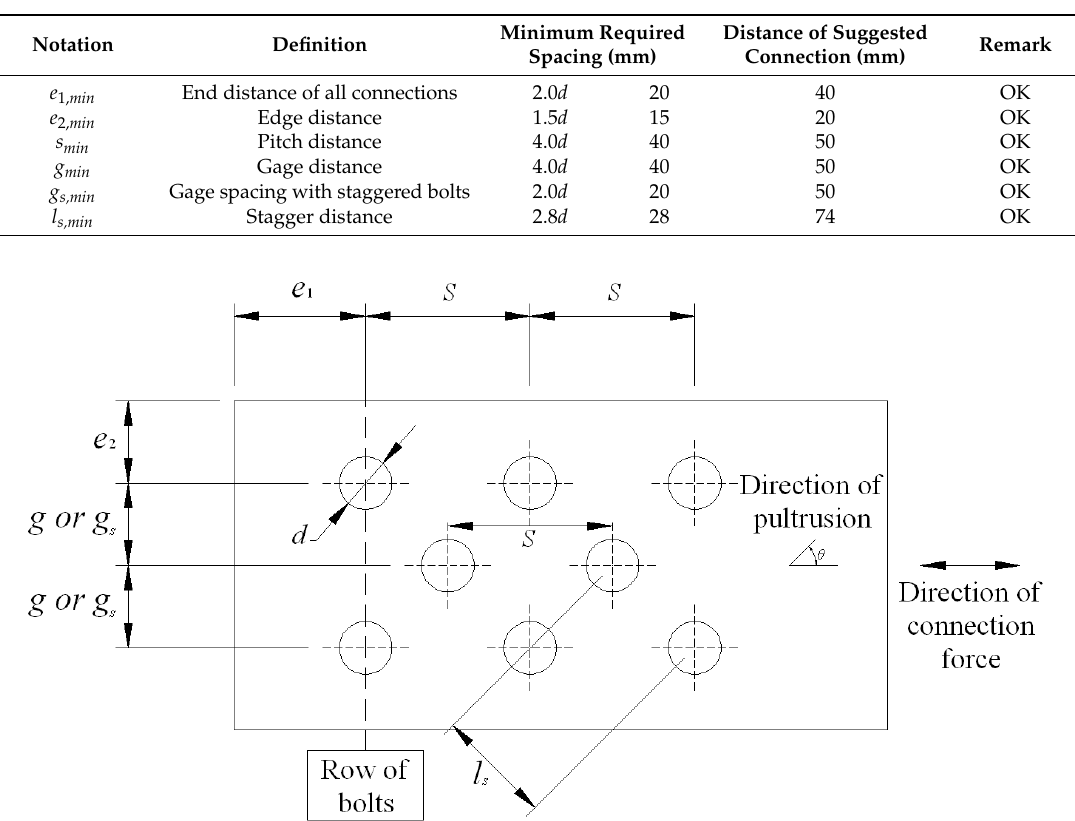
Table 5. Minimum requirements of bolted connection geometries.